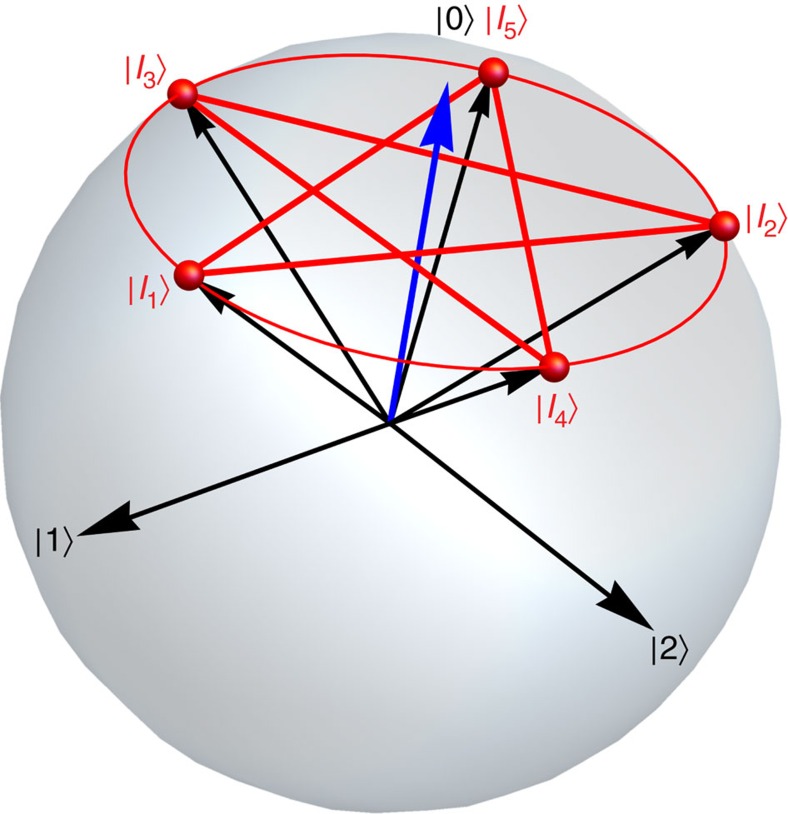
KCBS pentagram.The qutrit eigenstates are |i〉 with i=0, 1 and 2. One can construct five qutrit states |li〉 corresponding to five dichotomic observables Ai=2|li〉〈li|−1. States connected by edges of the pentagram are orthogonal, assuming compatibility of the associated observables. Each pair of compatible measurements forms a context, and each observable is included in two different contexts. The states of the pentagram are chosen to provide maximum contradiction with noncontextual HV models.